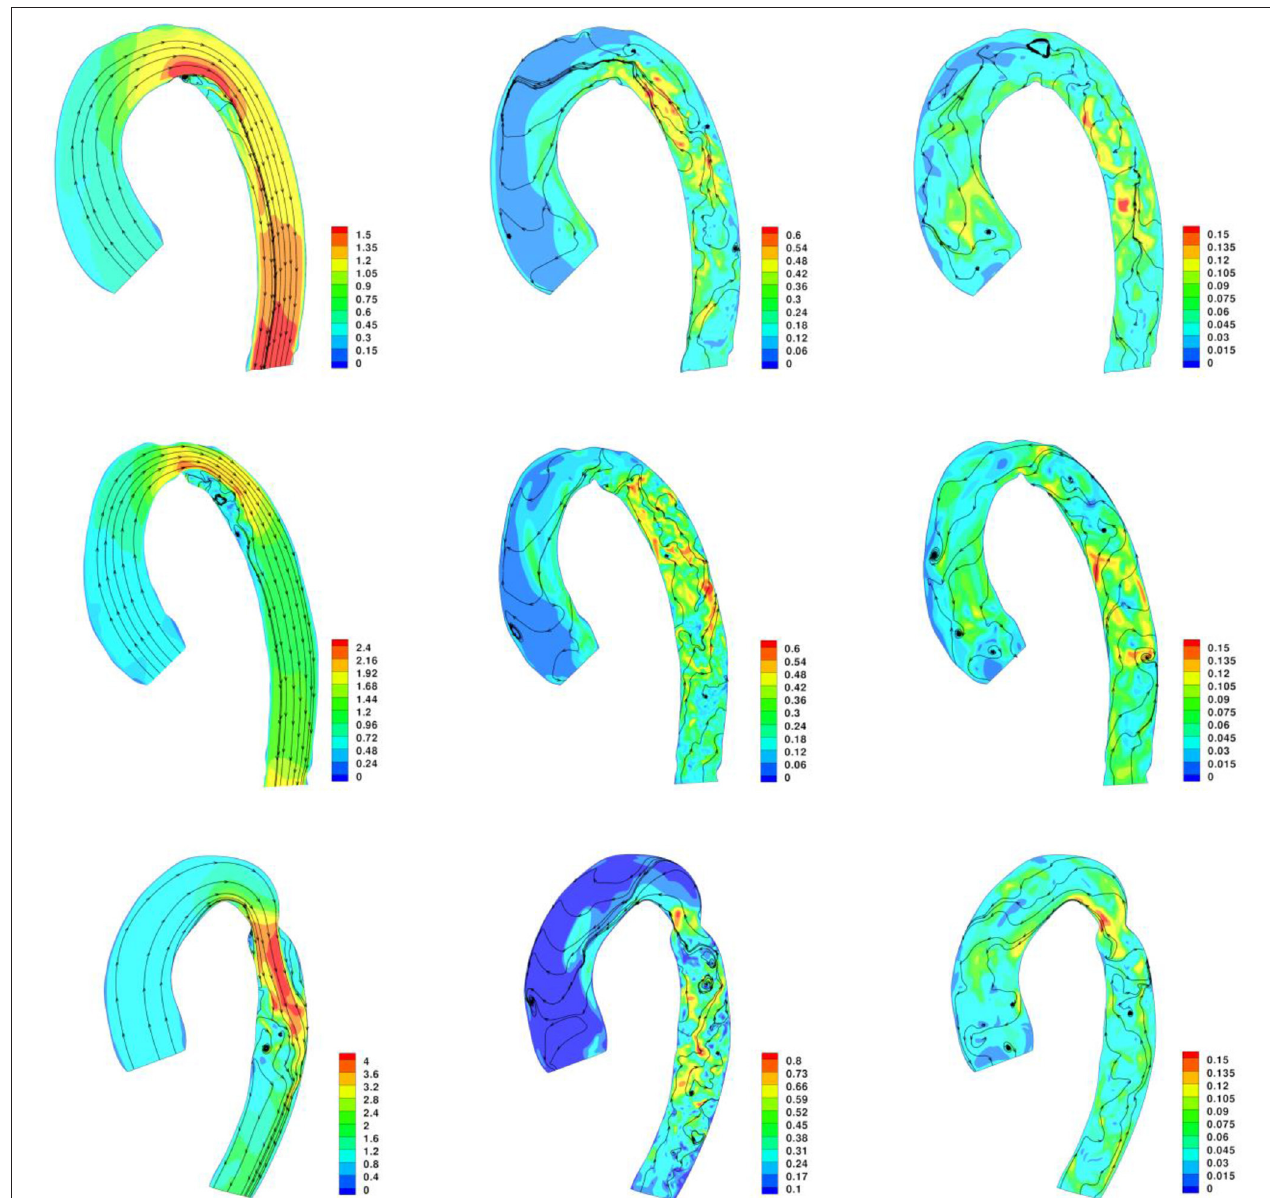
FIGURE 8 | Contour of velocity and velocity streamlines along the aorta at peak systole, end systole, and end diastole. Top row: No-CoA aorta; Middle row: r-CoA; Bottom Row: